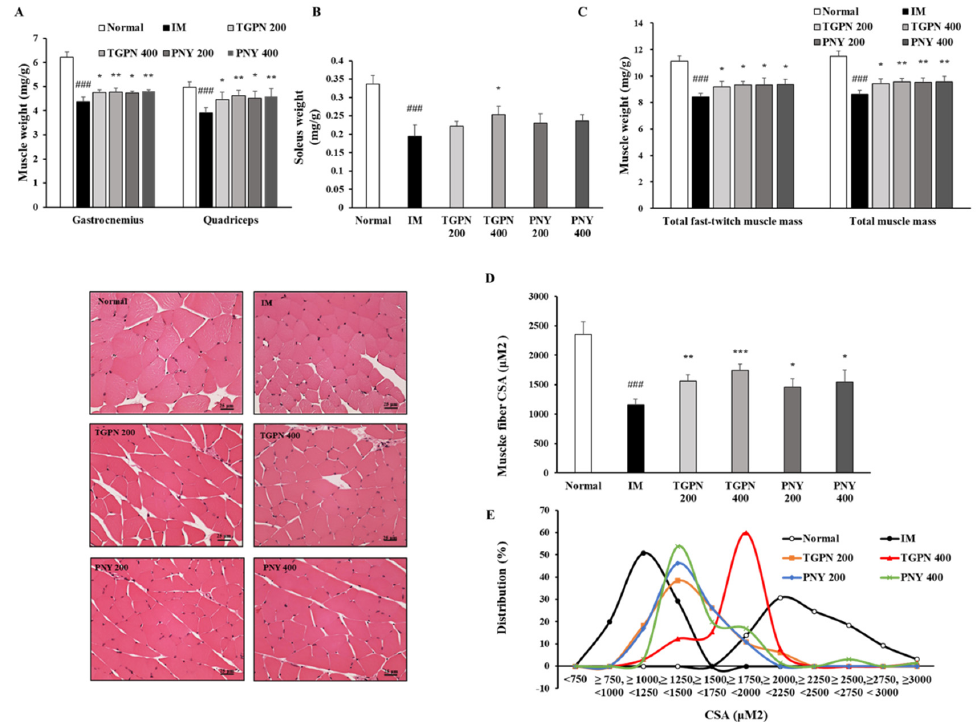
Figure 5. Effect of TGPN and PNY on body composition. Mice were subjected to hindlimb immobilization for one week, except for the normal group, and then administered with TGPN 200, 400 mg/kg, or PNY 200, 400 mg/kg for two weeks with continuous immobilization. ( A ) The fast-twitch muscle mass (gastrocnemius, quadriceps). ( B ) The slow-twitch muscle mass (soleus). ( C ) The total fast-twitch muscle mass and total muscle mass. Muscle mass was normalized to the bodyweight. ( D ) The cross-sectional area (CSA) of gastrocnemius muscle fiber. ( E ) The distribution graph of muscle fiber CSA. The scale bar is 25 μ m. The data are shown as mean ± SD. ### p < 0.001 versus normal, * p < 0.05, ** p < 0.01, *** p < 0.001 versus IM.